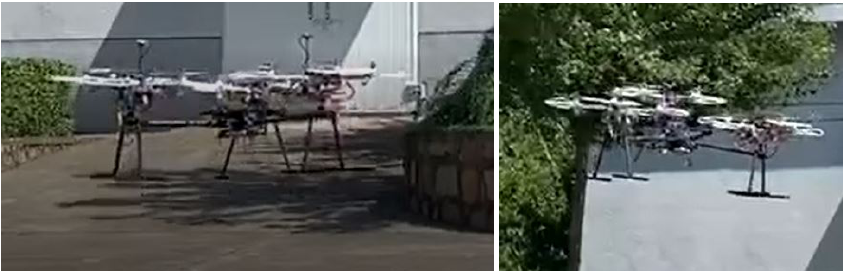
Figure 8. The IAP prototype maintaining a hover while changing its roll and pitch